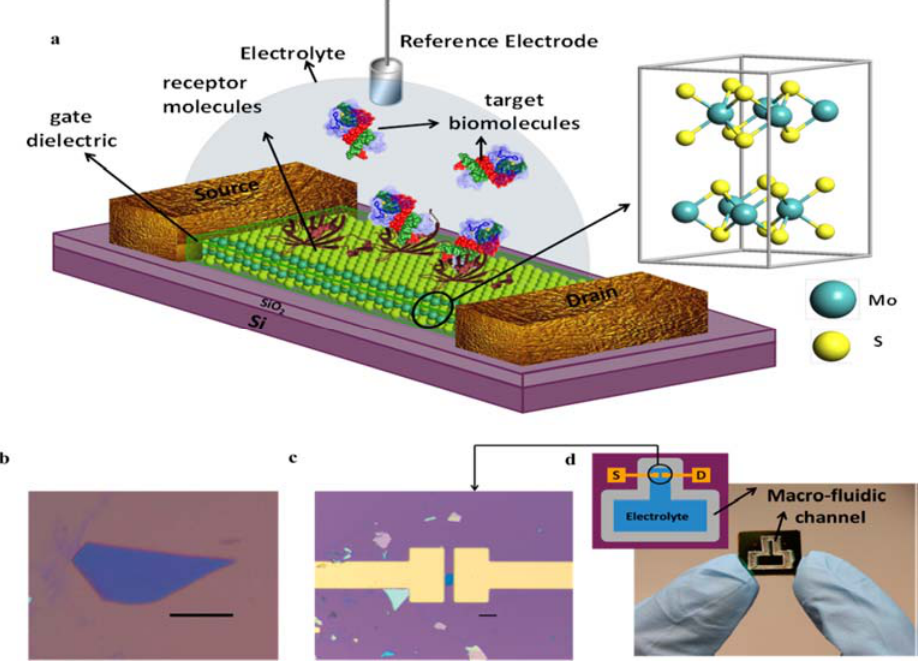
Figure 5. MoS 2 -based field-effect transistor (FET) biosensor device. ( a ) Schematic diagram of MoS 2 -based FET biosensor. For biosensing, the dielectric layer covering the MoS 2 channel is functionalized with receptors for specifically capturing the target biomolecules. The charged biomolecules after being captured induce a gating effect, modulating the device current. An electrolyte gate in the form of an Ag/AgCl reference electrode is used for applying the bias to the electrolyte. The source and drain contacts are also covered with a dielectric layer to protect them from the electrolyte (not shown in this figure). ( b ) Optical image of a MoS 2 flake on 270 nm SiO 2 grown on degenerately doped Si substrate. Scale bar, 10 µ m. ( c ) Optical image of the MoS 2 FET biosensor device showing the extended electrodes made of Ti/Au. Scale bar, 10 µ m. ( d ) Image and schematic diagram (inset figure) of the chip with the biosensor device and microfluidic channel for containing the electrolyte. Inlet and outlet pipe for transferring the fluid and the reference electrode are not shown in the figure. Reprinted with permission from ref. [26]. 2014 American Chemistry Society